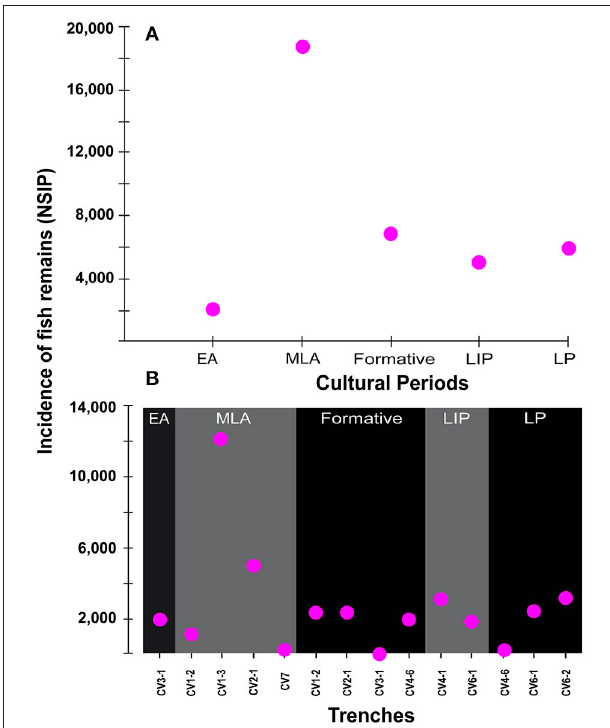
FIGURE 4 | (A) Incidence of fish remains present in shell middens for each of the major cultural periods excavated in the Caleta Vitor archeological area. (B) Same as for (A) , but for each of the archaeological sites at Caleta